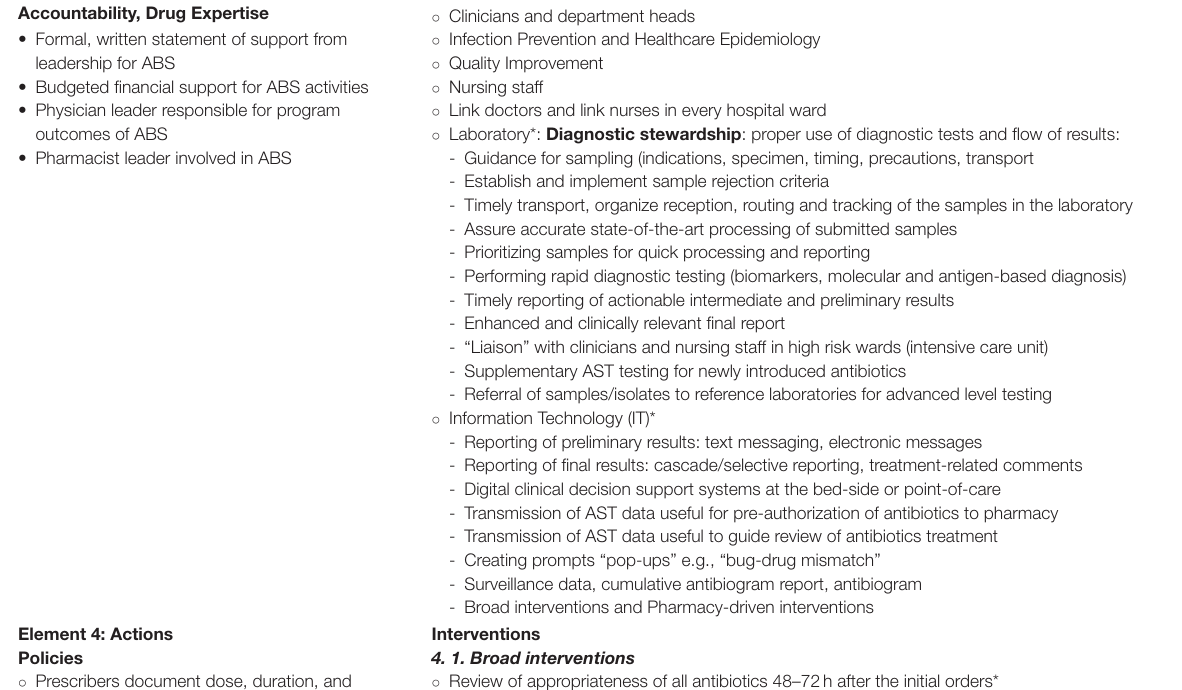
TABLE 2 | How the clinical bacteriology laboratory can contribute to antibiotic stewardship in hospitals. Core